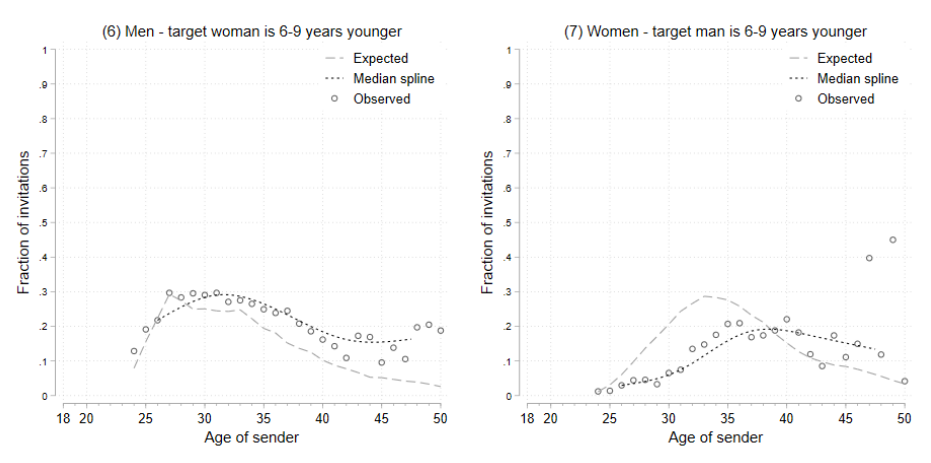
Figure 6 and 7 : Observed and expected fractions of initial messages sent to 6-9 years younger partners